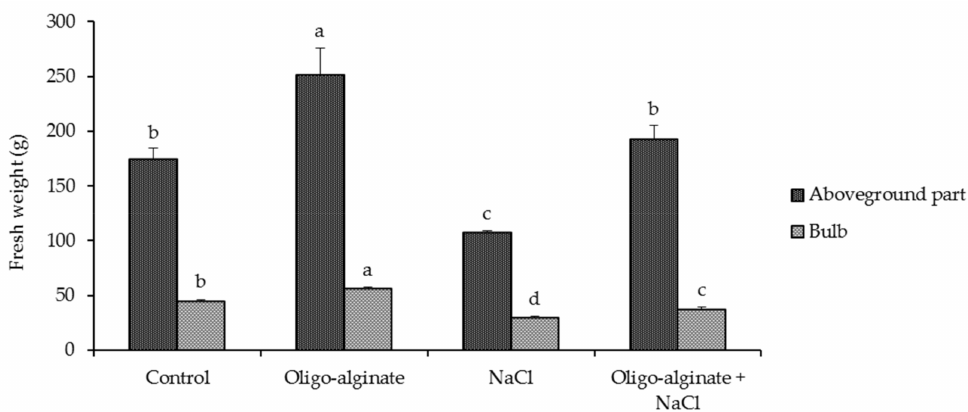
Figure 3. Effect of oligo-alginate and NaCl on fresh weight of above-ground part and bulb of Eucomis autumnalis . Data are presented as means ( ± standard errors) and bars with different letters in each graph are significantly different by Tukey Test ( p ≤